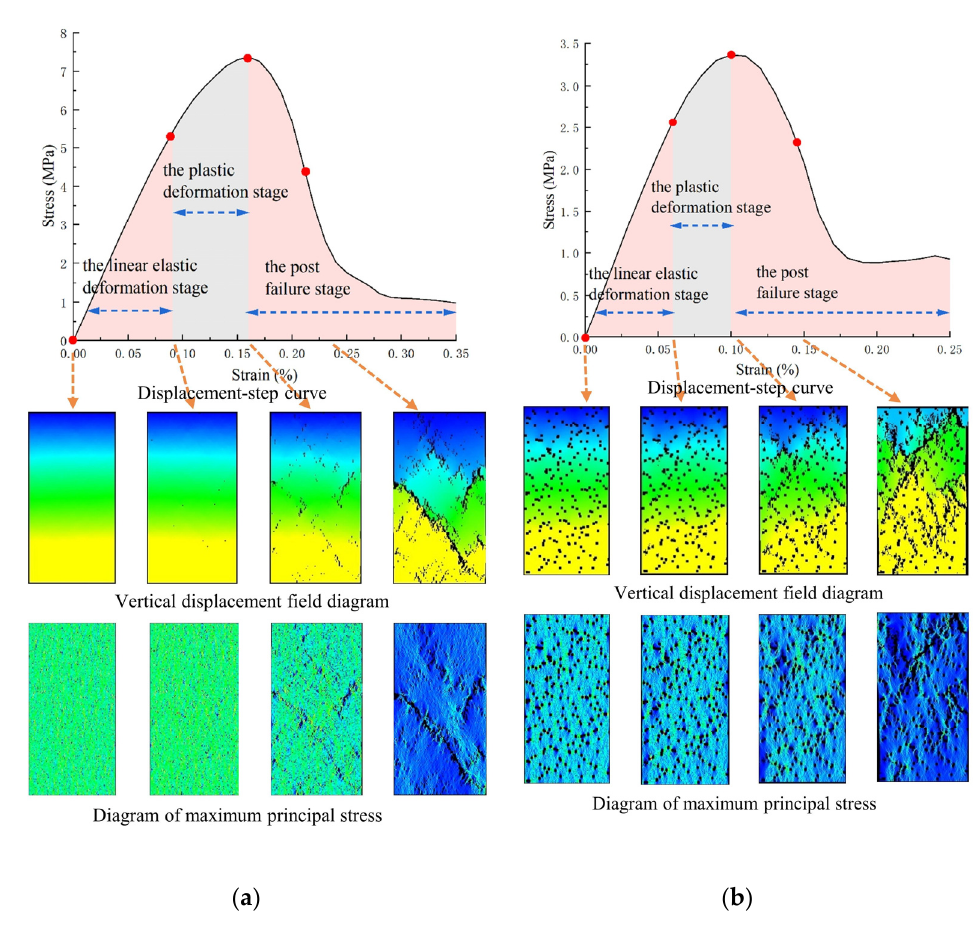
Figure 4. Stress field and displacement field evolution clouds. ( a ) Cloud diagram of the evolution of stress and displacement fields of specimens without porosity. ( b ) Cloud diagram of stress and displacement field evolution of pore specimen.